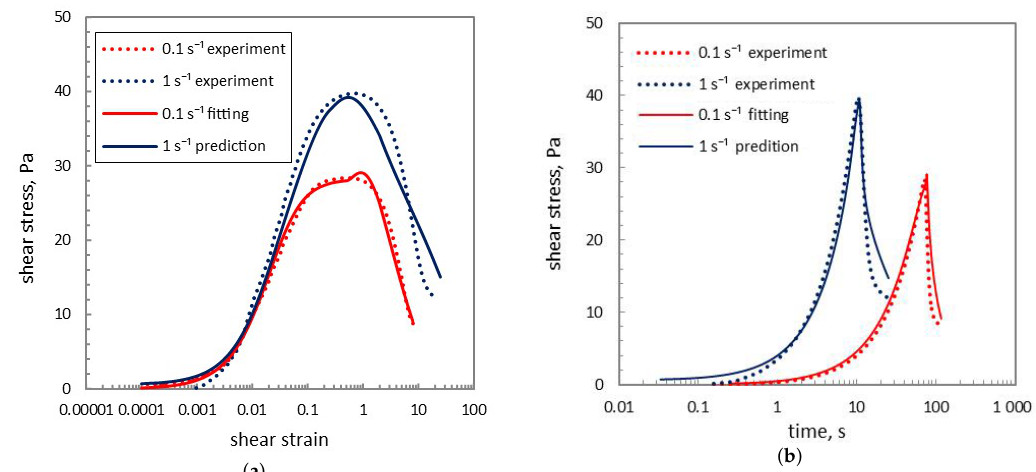
Figure 10. Fitting curves for shear rate ˙ γ = 1 s − 1 and ˙ γ = 0.1 s − 1 using the elastic modulus. model under the double- network assumption, and the shear rate history with inertial overshoot Equation (21) (with the fitting values in Table 2): ( a ) shear stress as a function of shear strain; ( b ) shear stress as a function of time. The curves for ˙ γ = 1 s − 1 are predicted by the model with the same parameters used to fit the 0.1 s − 1 curves, and are presented in Figure 10 with navy blue solid lines. The